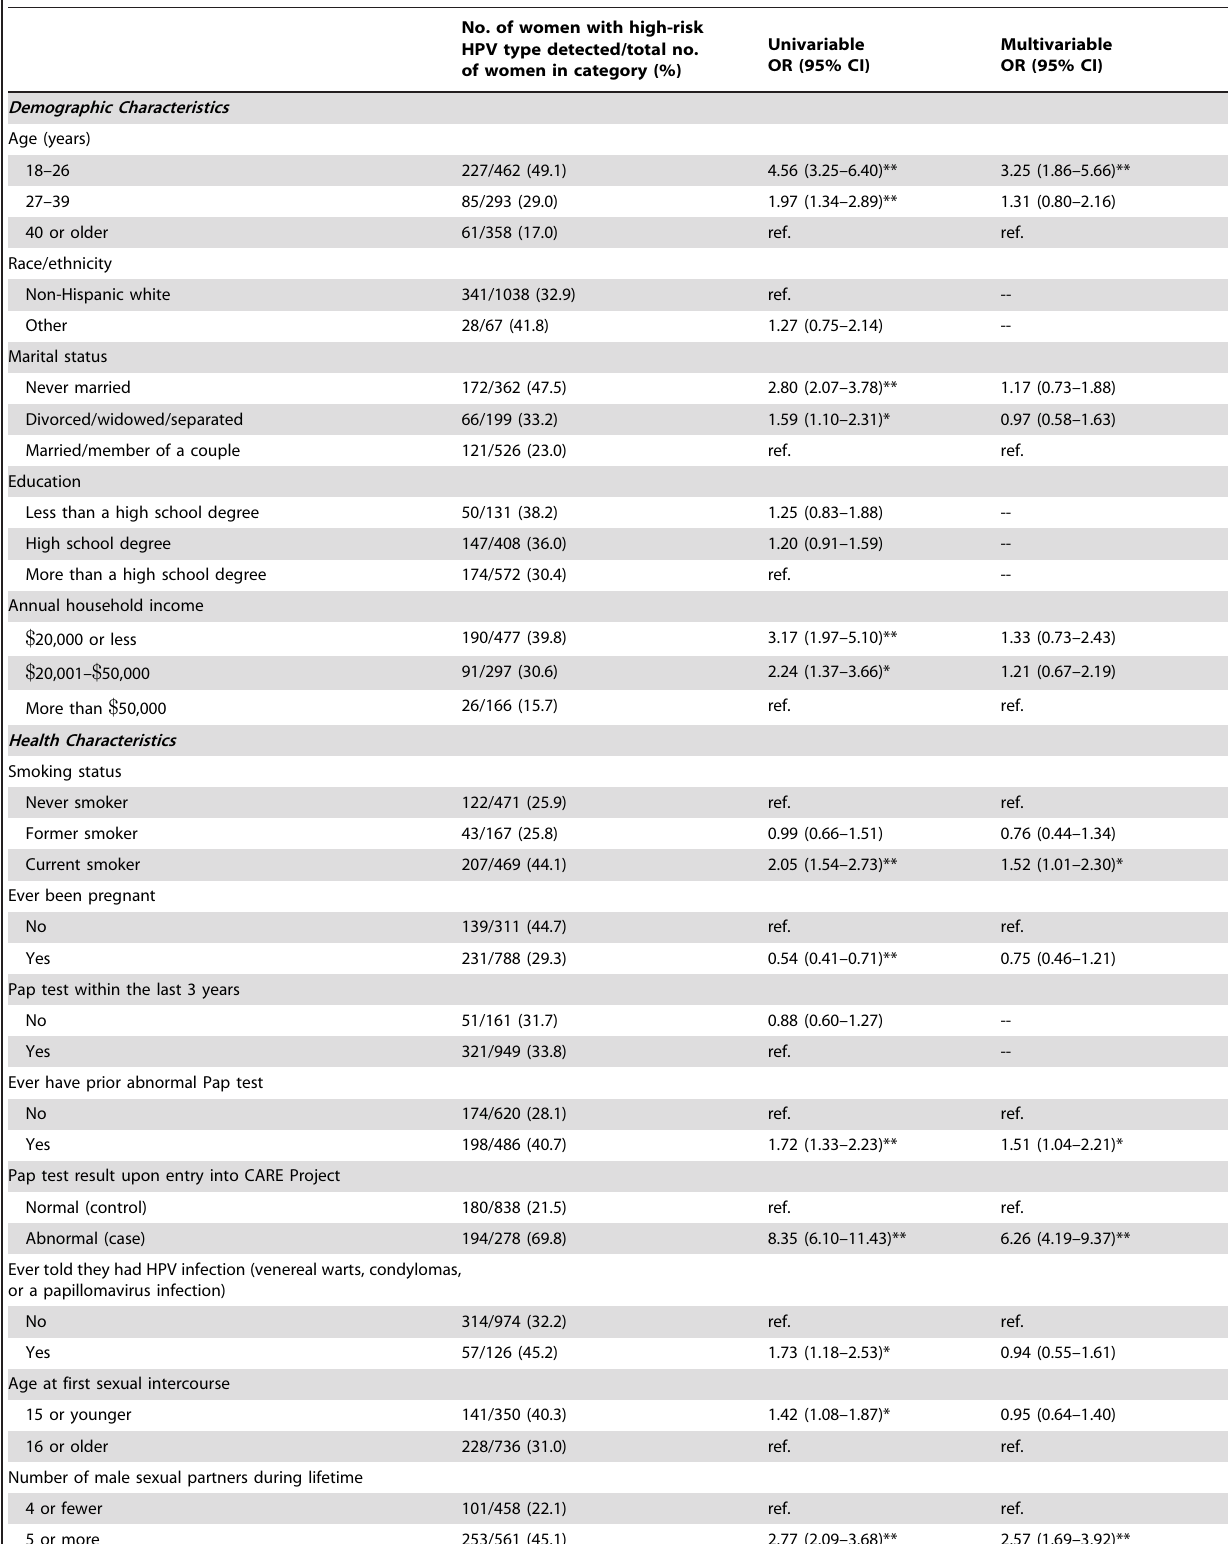
Table 5. Detection of high-risk HPV among women from the CARE Project (n=1116). a